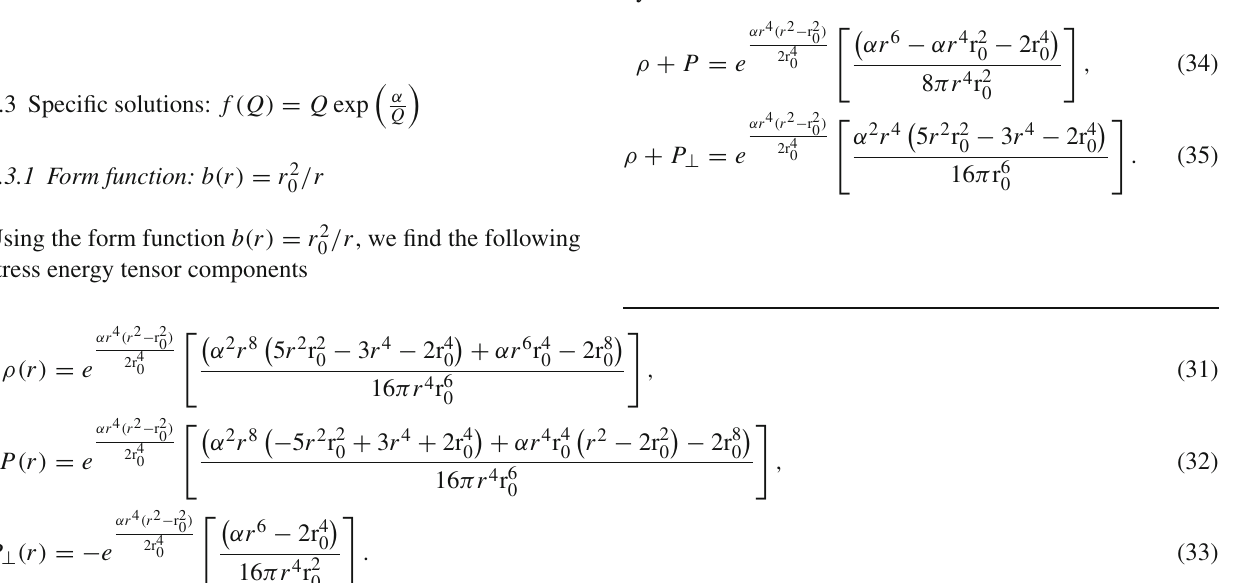
choice indicates that NEC is always violated at the wormhole